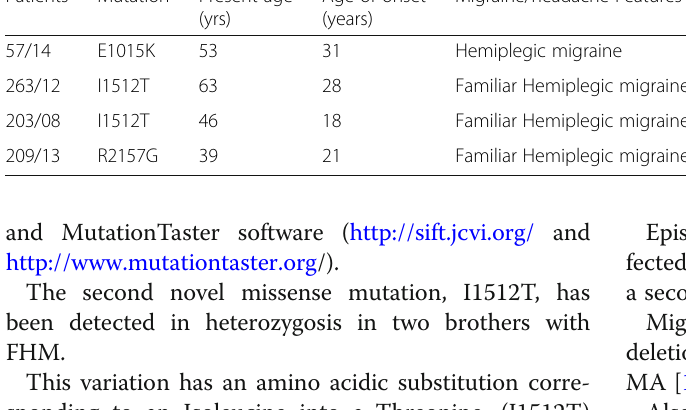
Table 2 List of detected point mutations and phenotypical features